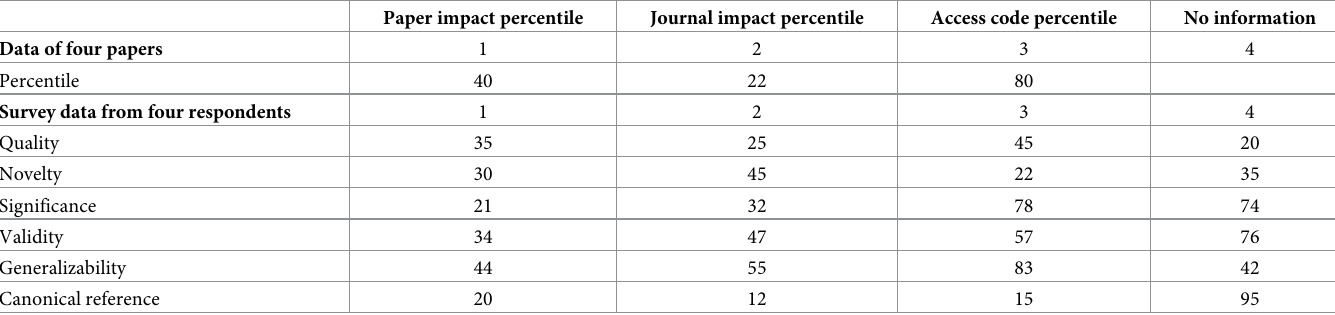
Table 3. Fictitious example data that are paper-based (e.g. the citation impact percentile) or respondent-based (e.g. the quality